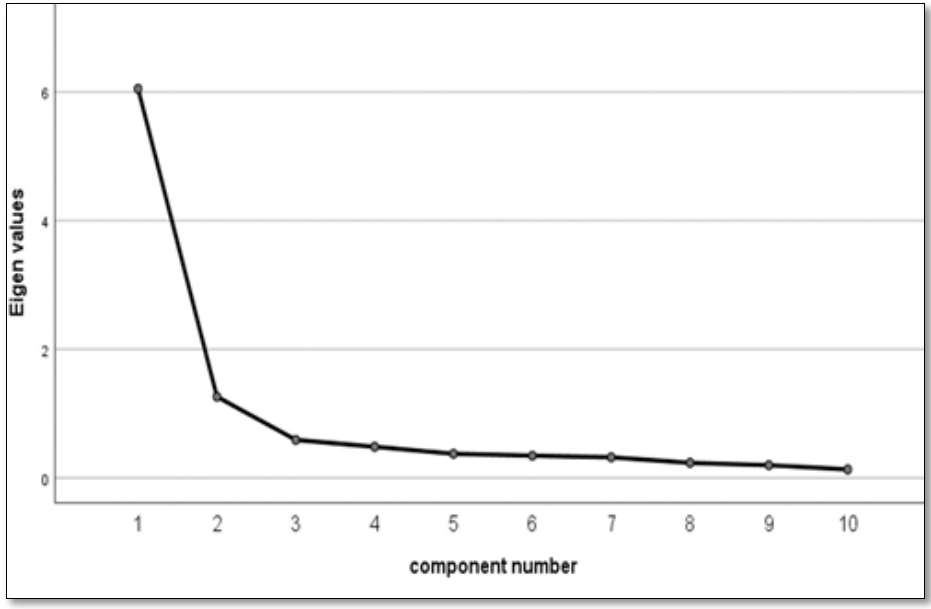
Figure 1. Scree Plot based in EFA of the FCV-19S. Table 3. Factor loadings of 10 items in test sample 1 (N =